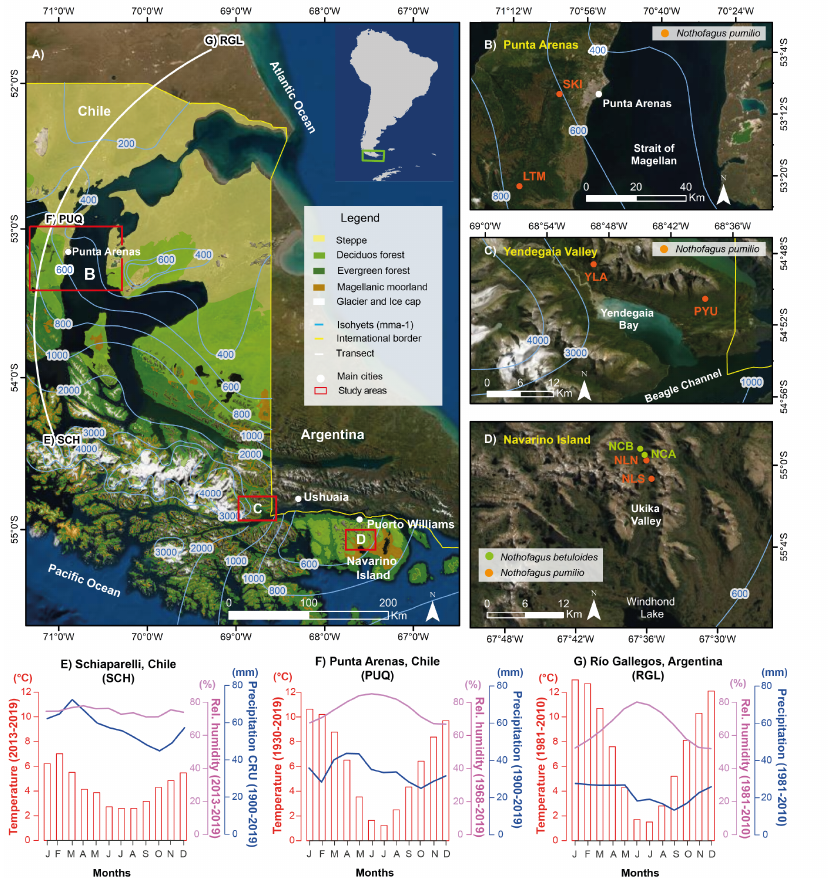
Figure 1. The geographical and climatic setting of the study area. ( A ) Location of the major towns of Punta Arenas, Ushuaia, and Puerto Williams (white circles) and overview of the three study areas (red boxes): ( B ) Punta Arenas outskirts (53°9 (cid:48) 36 (cid:48)(cid:48) S, 71°1 (cid:48) 54 (cid:48)(cid:48) W), ( C ) Yendegaia Valley (54°50 (cid:48) 17 (cid:48)(cid:48) S, 68°45 (cid:48) 17 (cid:48)(cid:48) W) and ( D ) Navarino Island (54°58 (cid:48) 50 (cid:48)(cid:48) S, 67°36 (cid:48) 23 (cid:48)(cid:48) W). Illustration of regional vegetation types [20,35]. The isohyets, glaciers, and political limits are derived from the state-owned geospatial data network IDE (https://www.ide.cl/, accessed on 1 May 2022). ( E – G ) Climate diagrams of three weather stations along a southwest to northeast transect (white line in A ), including monthly mean temperature ( ◦ C), relative humidity (%), and precipitation (mm). The map was created using Esri